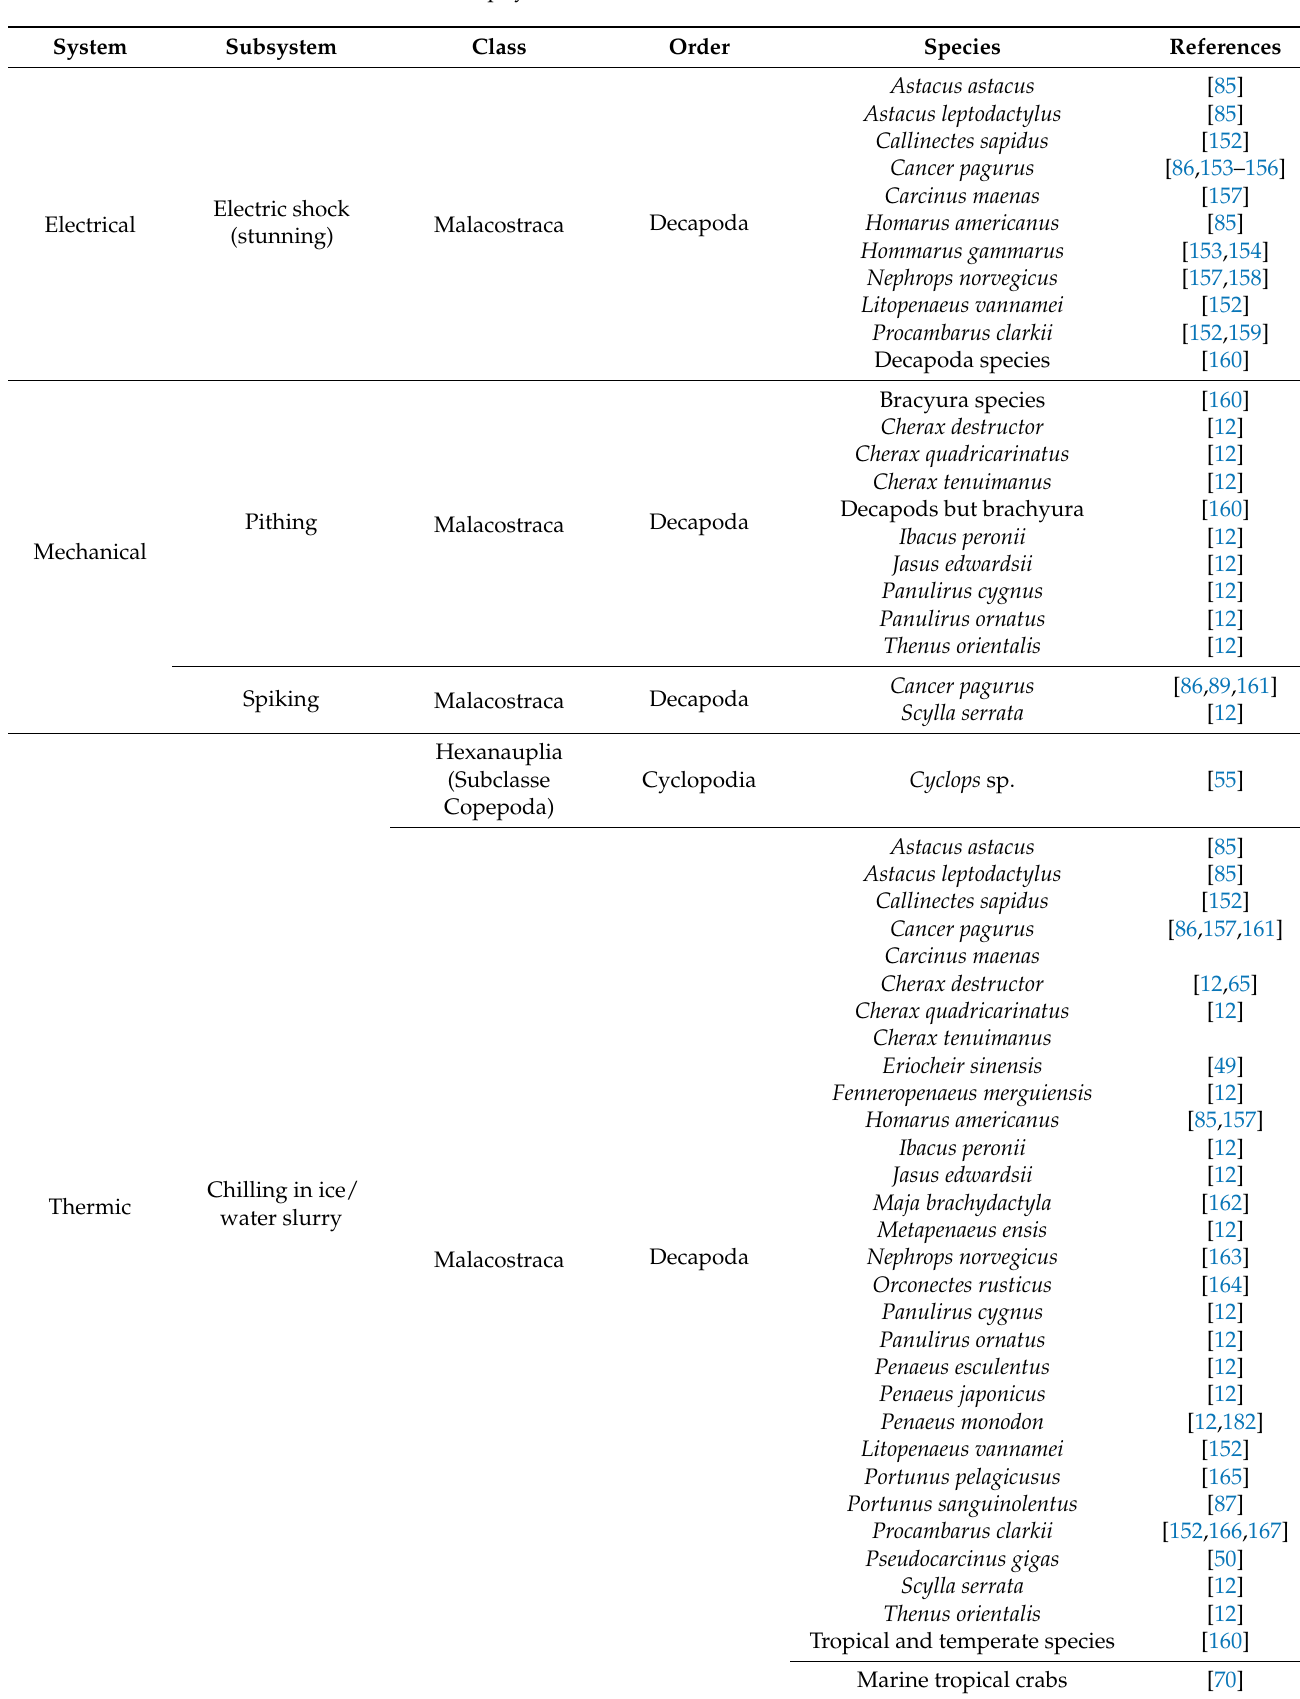
Table 3. List of physical methods used in